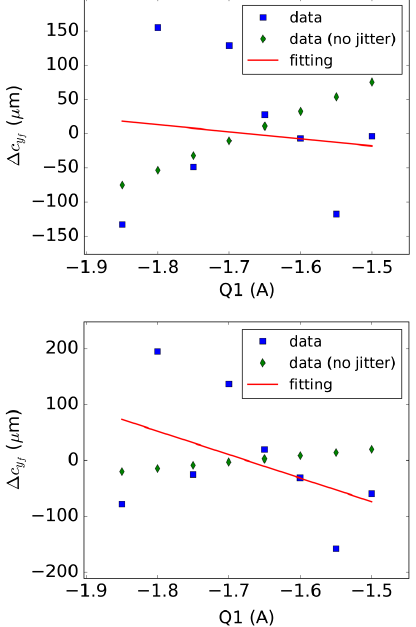
FIG. 7. Errors of the simulated vertical displacements with 300 random RFD voltages (rms jitter 0.1%) and phases (rms jitter 0.1°), respectively. Q1 is used for scanning.